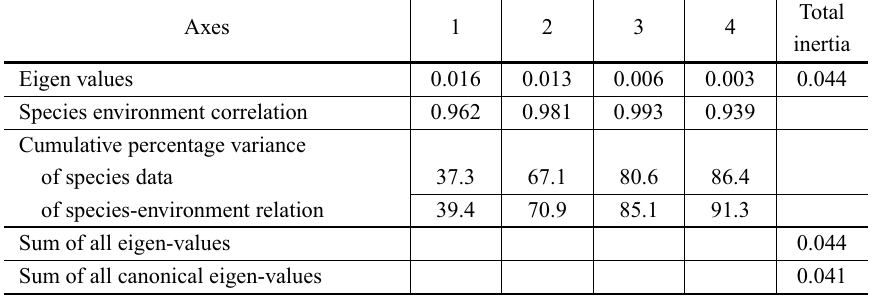
All four eigen-values reported above are canonical and correspond to axes that are constrained by the environ- mental variables.